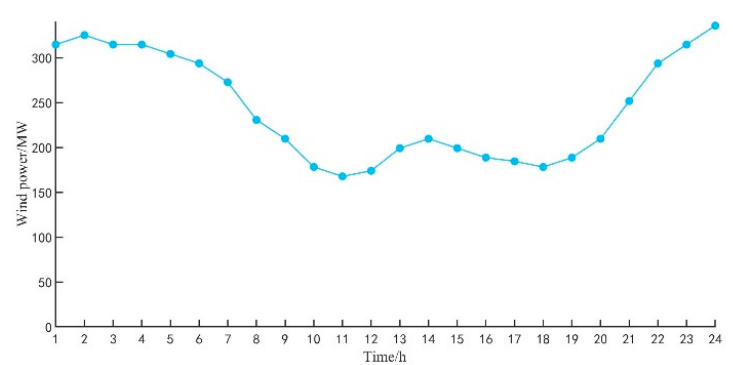
Figure A3. Typical daily wind power generation for planning.